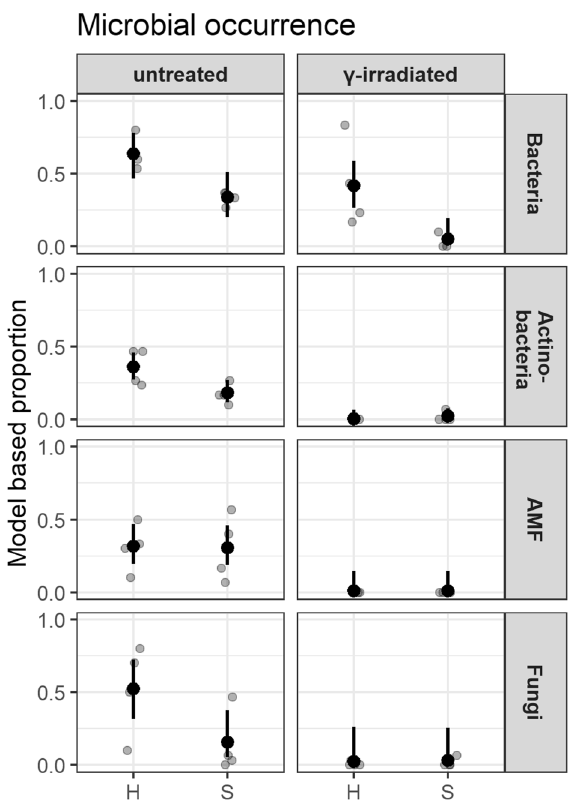
Figure 5. Occurrence of microorganisms in fine roots of R. corymbifera ‘Laxa’ grown in untreated or γ-irradiated soil from replant diseased sites Heidgraben (H) and Sangerhausen (S), respectively. Proportions of root segments rated for bacteria, actinobacteria, arbuscular mycorrhiza fungi (AMF), and other fungi. Given are observed proportions per plant (grey dots), mean proportions driven from the models (black dots), and 95% confidence intervals for the mean proportions (black bars) from 30 root segments of n = 4 plants. Significant differences (α = 0.05) were found for the occurrence of bacteria in Heidgraben γ-irradiated vs. Sangerhausen γ-irradiated ( p = 0.027) and for actinobacteria in Heidgraben untreated vs. Heidgraben γ-irradiated ( p < 0.01), as well as for actinobacteria in Sangerhausen untreated vs. Sangerhausen γ-irradiated ( p = 0.016). This figure was created using the software R version 3.6.1 (R Core Team 2019, https:// www.R- proje ct. org/) 48,51,52,54